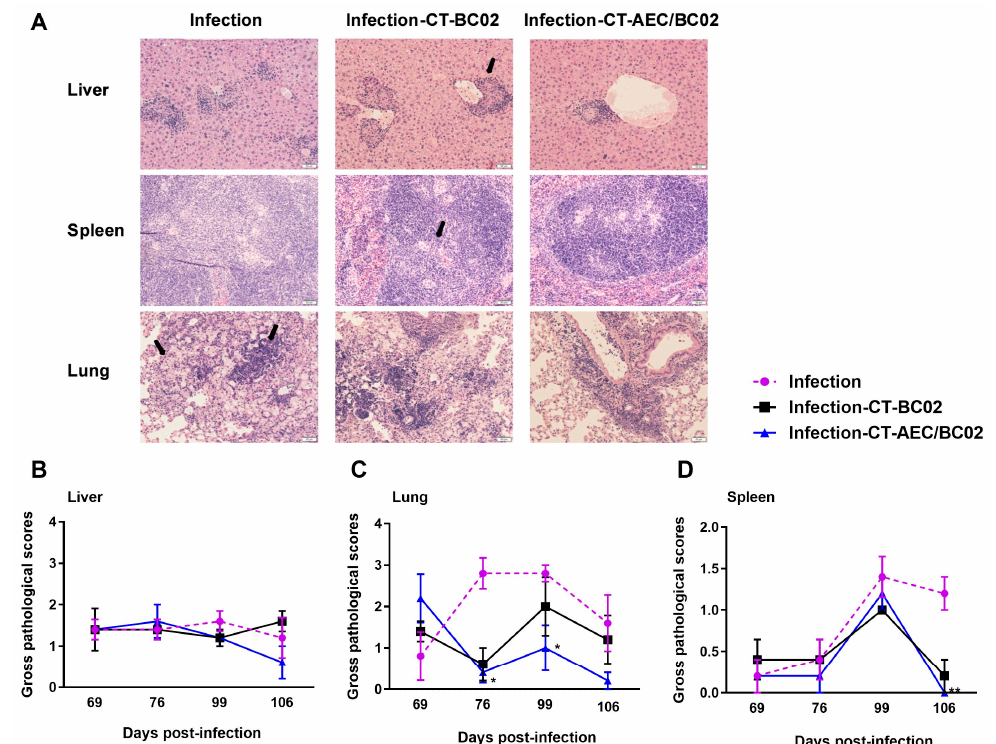
Figure 3. Evaluation of the immunotherapeutic effects of AEC/BC02 vaccine on tissue pathology in the livers, lungs, and spleens in Mtb latently infected mice. ( A ) Pathological changes in the livers, lungs, and spleens of mice. Black arrows indicate granulomatous lesions of the livers and spleens, as well as the infiltration of monocytes and the accumulation of macrophages in the lungs. Pathological scores are shown for the livers ( B ), lungs ( C ), and spleens ( D ) of mice. The infection-CT-AEC/BC02 group was compared with the infection group, and statistical significance was set at * p < 0.05 or ** p < 0.01 ( n = 5).